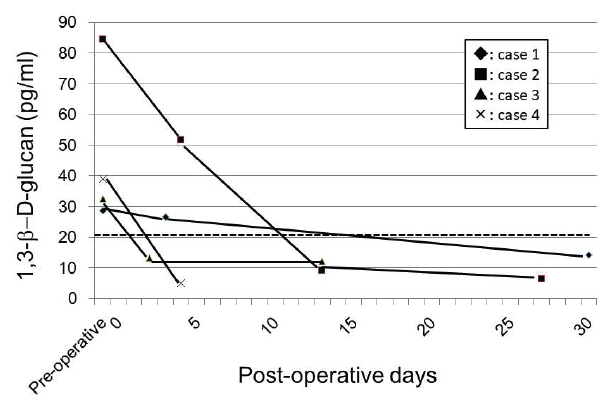
Figure 3. Time course of 1,3- b -D-glucan values before and after opera- tion in cases 1 to 4. The dotted line shows the upper limit of the normal